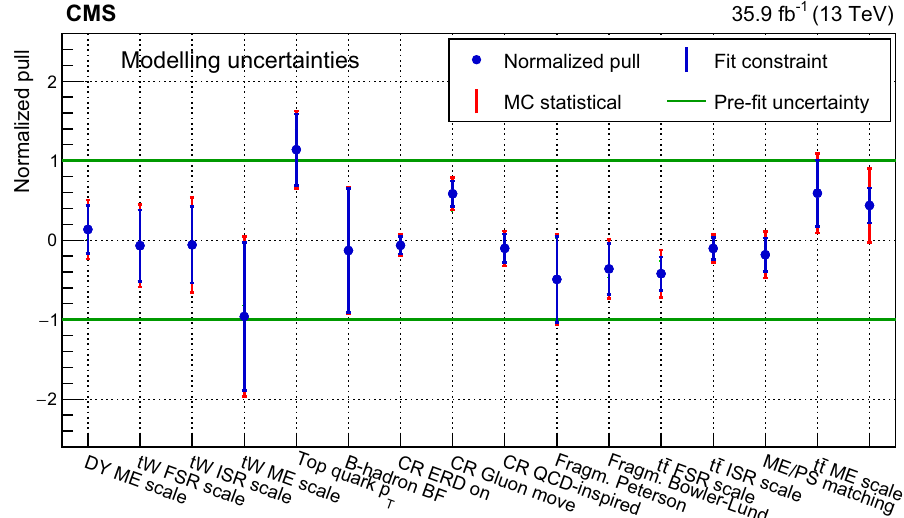
Fig. 7 Normalized pulls and constraints of the nuisance parameters relatedtothemodellinguncertaintiesforthecrosssectionfit.Themark- ers denote the fitted values, while the inner vertical bars represent the constraint and the outer vertical bars denote the additional uncertainty as determined from pseudo-experiments. The constraint is defined as